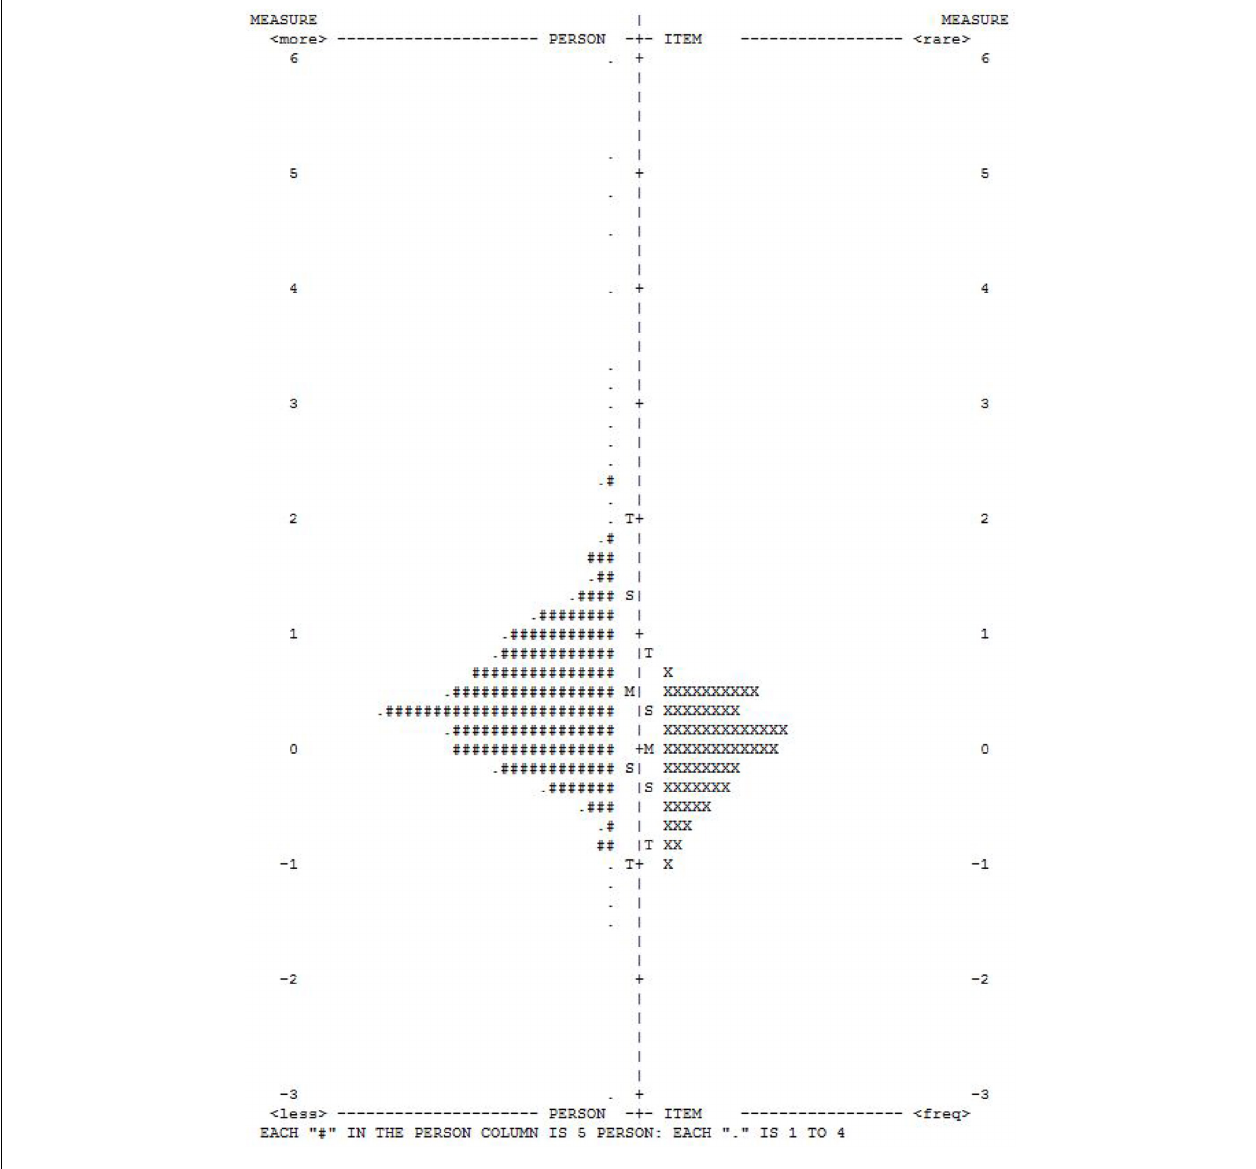
Frontiers in Education |